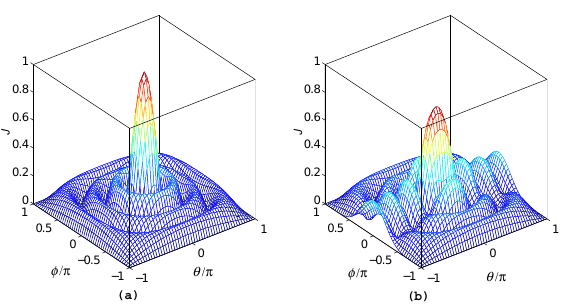
Fig. 3 Local traps induced by SU .2/ dynamical symmetry: (a) when the target gate is inside the SU .2/ subgroup; (b) when the target gate is outside the SU .2/ subgroup. Reproduced with permission from Ref. [47], (cid:13) C 2011 APS.